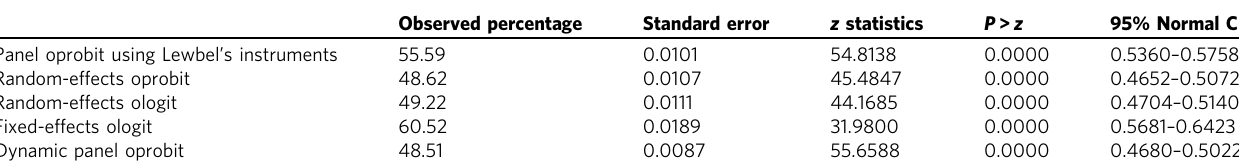
Table 6 Bootstrapped results for the percent of followers (replicating 400